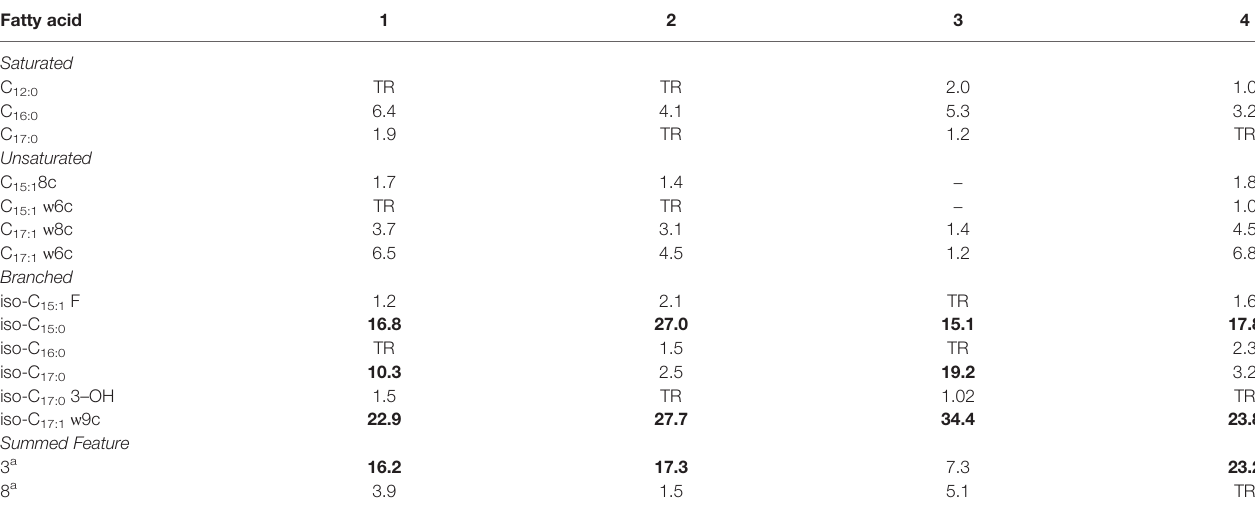
TABLE 2 | Cellular fatty acid composition (%) of strains A6E486 T and 5E331 T and experiment control strains. Fatty